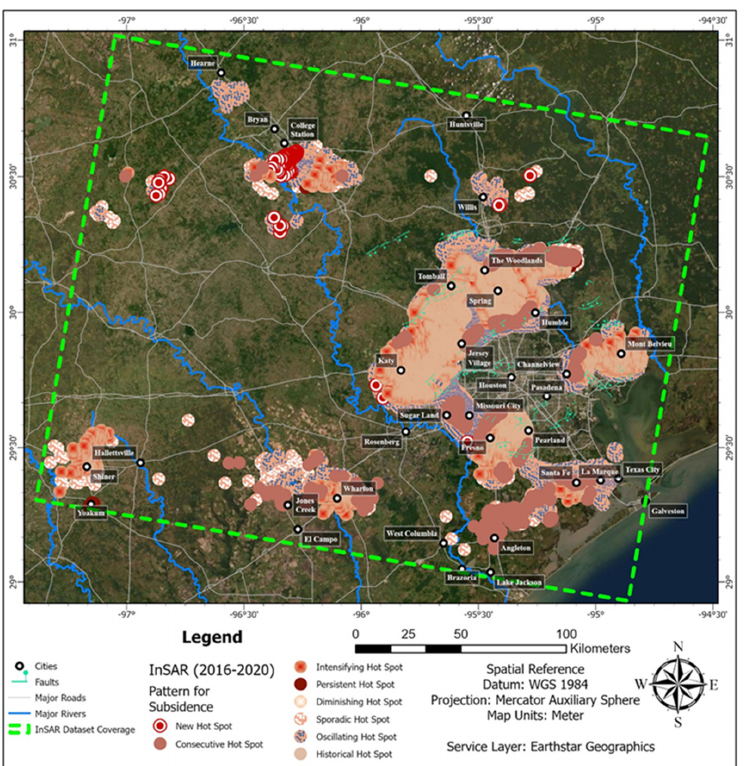
Figure 4. Emerging hot spot results for subsidence in Houston and surrounding areas. A neighbor- hood distance of 10 km was used and only the eight hot spot (high value trend) categories were shown.